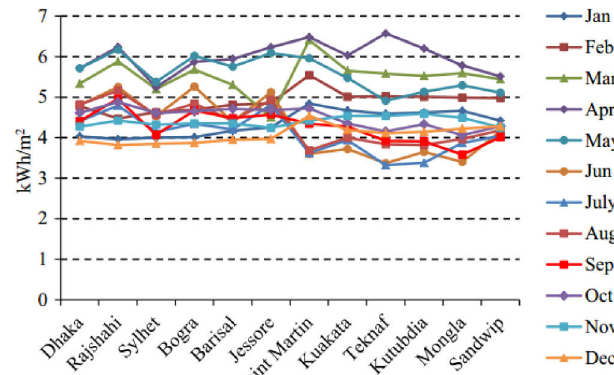
Figure 7: Solar Irradiation of different areas in Bangladesh